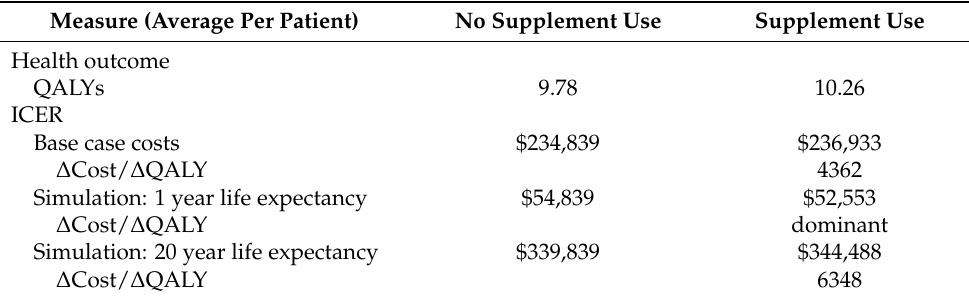
Table 3. Incremental cost-effectiveness ratios and health outcome, by supplement use.